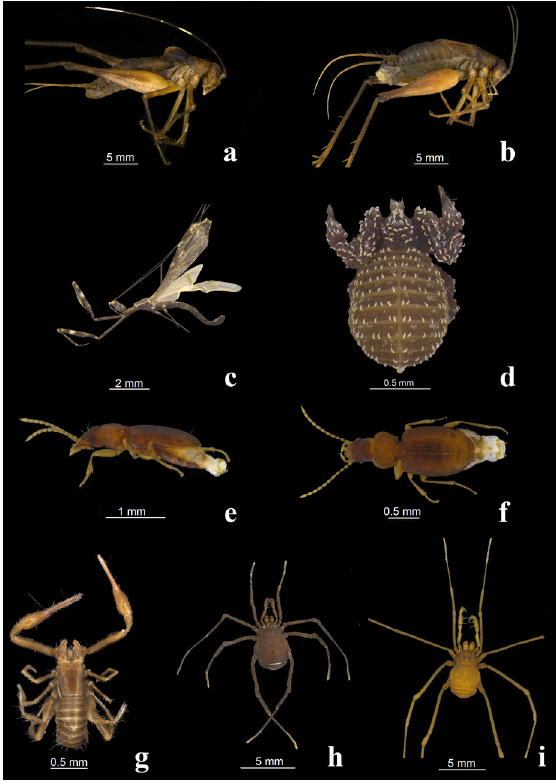
Figure 2 - Taxa recorded in Presidente Olegário caves,